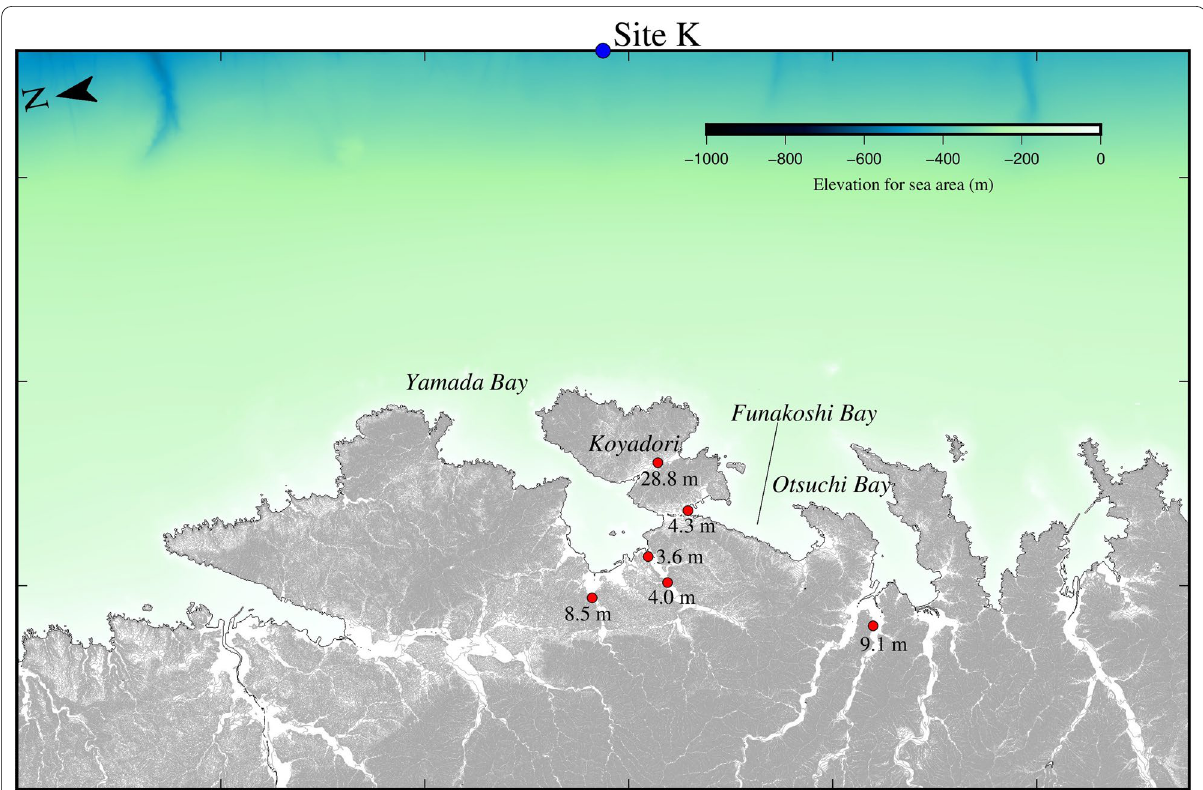
Fig. 2 Computational area considered for the numerical experiment. The upper boundary of the domain corresponds to an incident boundary, and red circles indicate targeted observation sites with the observed heights (Ebina and Imai 2014). The tick interval was 10